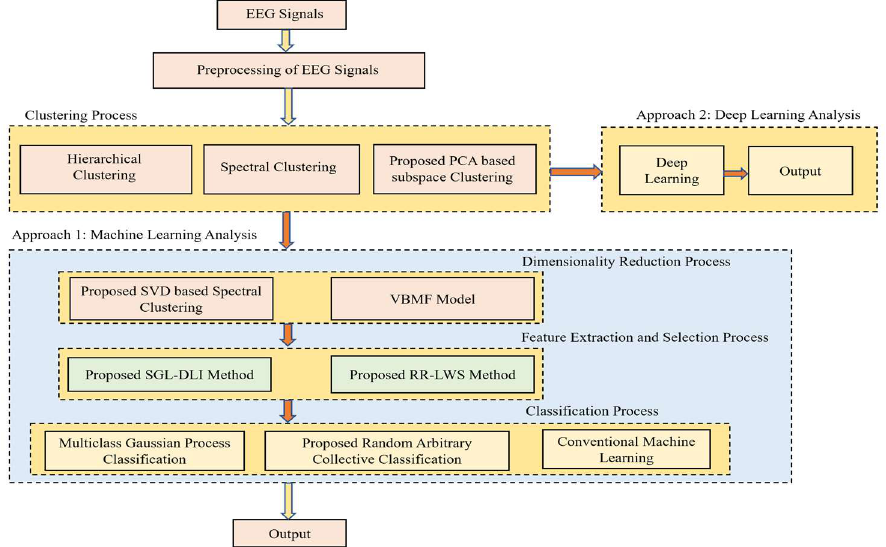
Figure 1. Pictorial representation of the work.